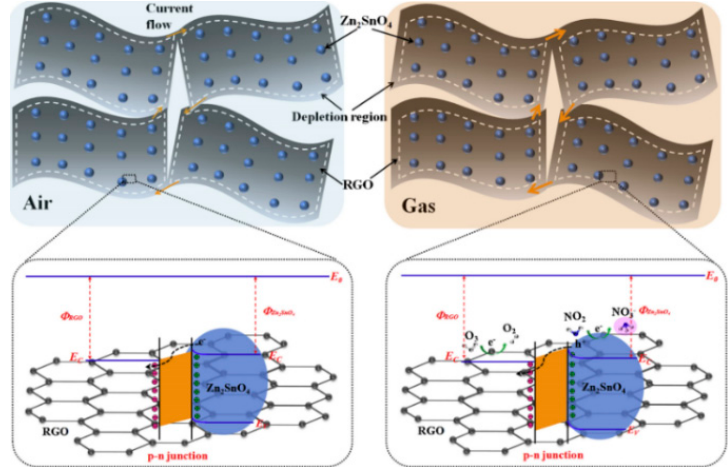
Figure 16. The representative models of Zn 2 SnO 4 -RGO hybrids: schematic illustration of the energy band structures and the form of p-n heterojunction in air and oxidizing gases [64].